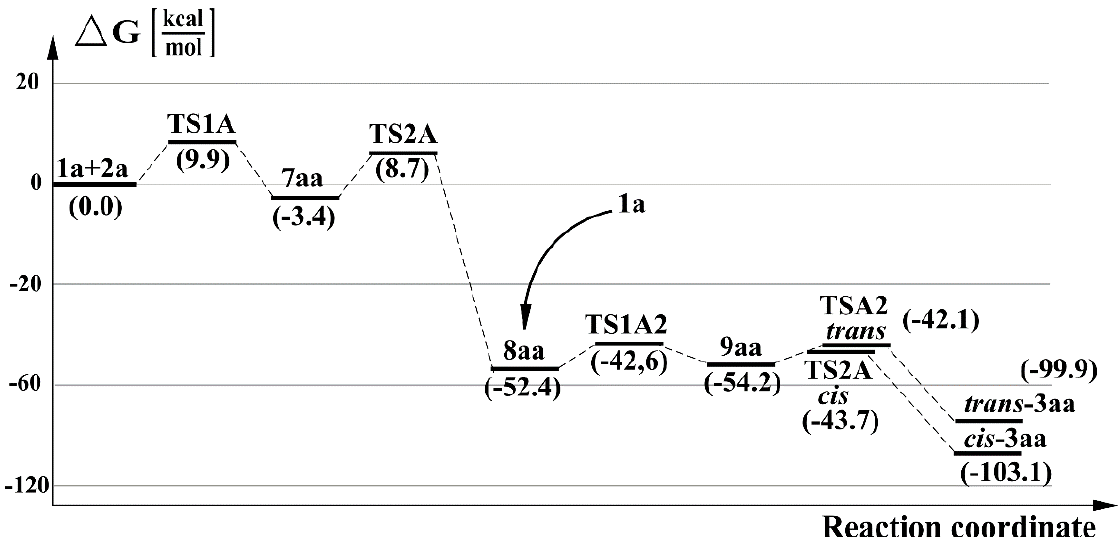
Figure 3. Gibbs free energy profile for the reaction of dichlorocarbene ( 1a ) with 2,2,4,4-tetra-methylcyclobutane-1,3-dithione ( 2a ) in the light of wb97xd/6-311g(d,p)(PCM) computational study.